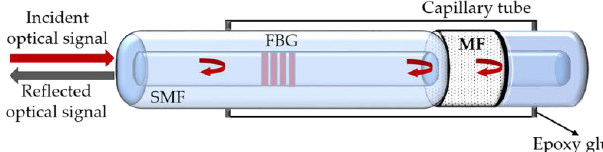
Figure 12. Schematic representation of a FPI based magnetic field sensor (adapted from [51]).